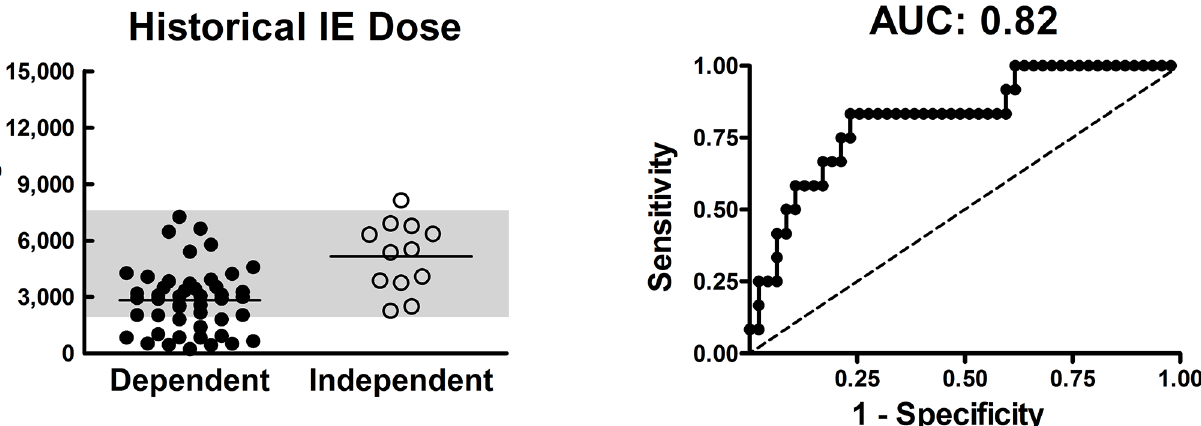
Fig 1. Previously published data showing overlap and correlation of islet equivalent dose with clinical transplant outcome. Data from Anazawa et al . [10] illustrating that the islet equivalent ( IE ) dose correlates with the clinical outcome [insulin independence vs. dependence] at 6 – 12 months following islet autotransplant (IAT). However, the gray region indicates a wide range of IE dose (IE/kg of recipient) that is associated with an uncertain IAT outcome. The second graph shows the receiver operating characteristic (ROC) curve for this previously published data set with the area-under-the-curve (AUC) above.